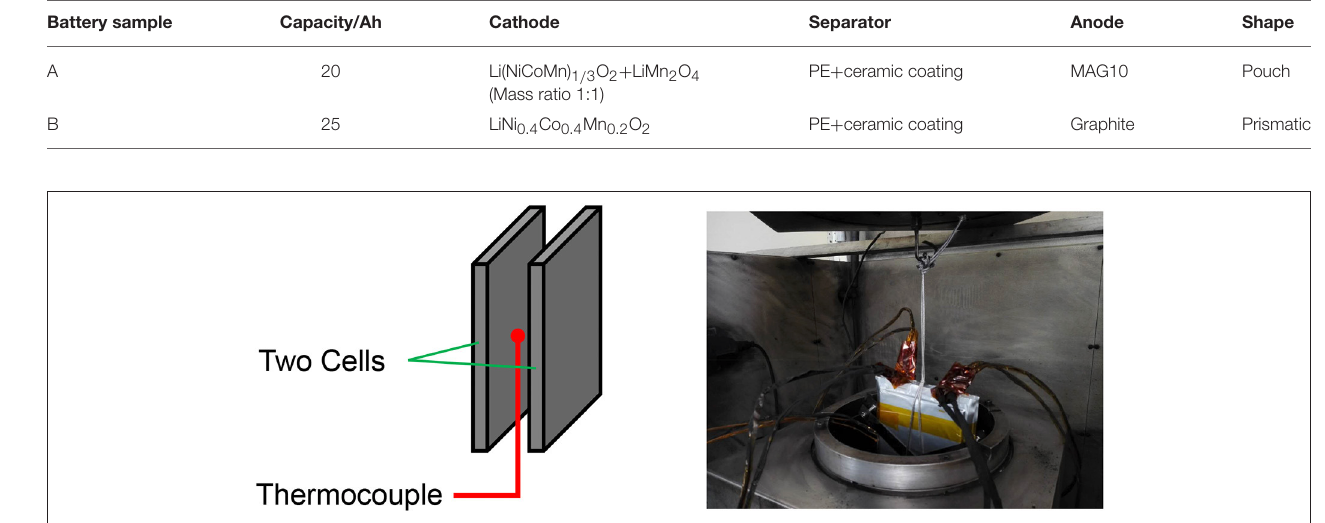
FIGURE 1 | Experimental settings for the ARC